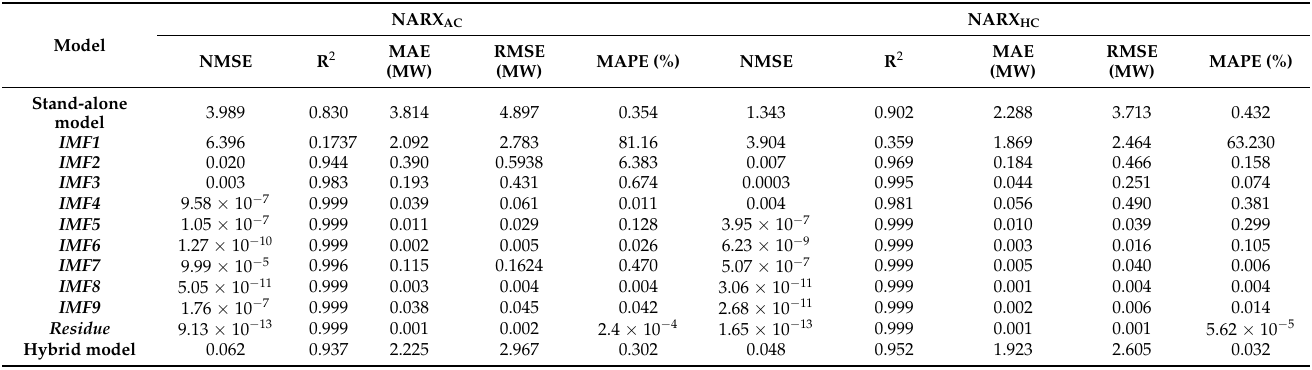
Table 5. Statistical comparisons among highly correlated (HC) and all correlated (AC) variables using NARX for the GS1